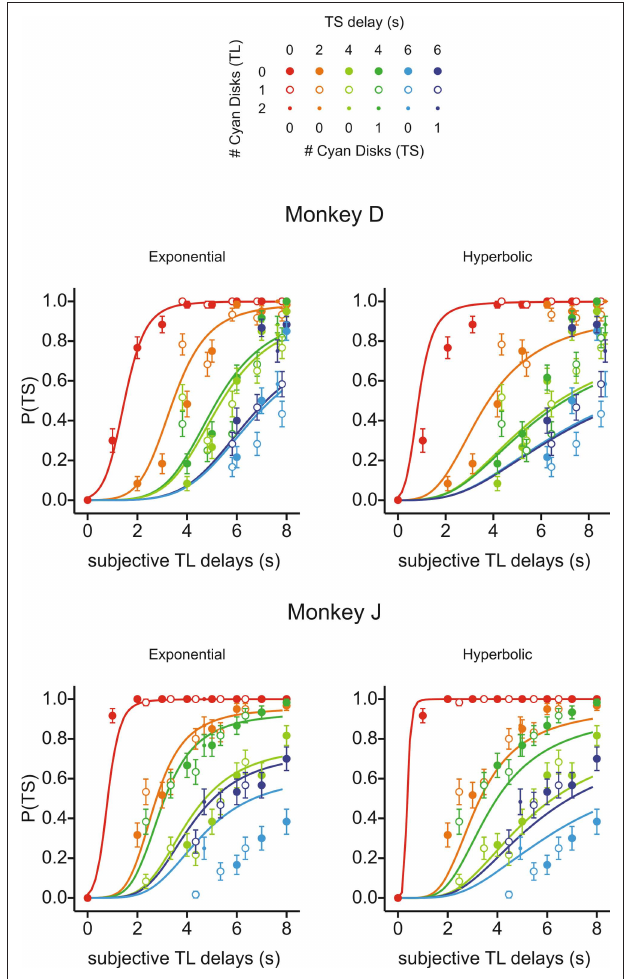
FIGURE 7 | Choice behaviors in Experiment III-A. The delays for large reward were calculated using the subjective delay for the cyan disk, whereas the physical reward delays and the number of cyan disks used for the small- reward and large-reward targets are indicated by the colors and sizes of the symbols. Lines indicate the predictions from the exponential (left) or hyperbolic (right) discount functions. Error bars, SEM.